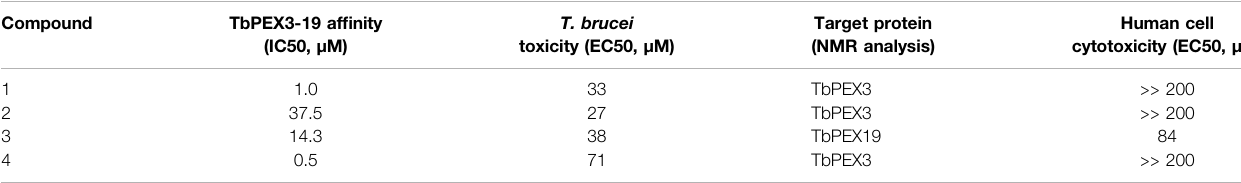
TABLE 2 | Comparison of drug properties from in vitro and in vivo analyses.